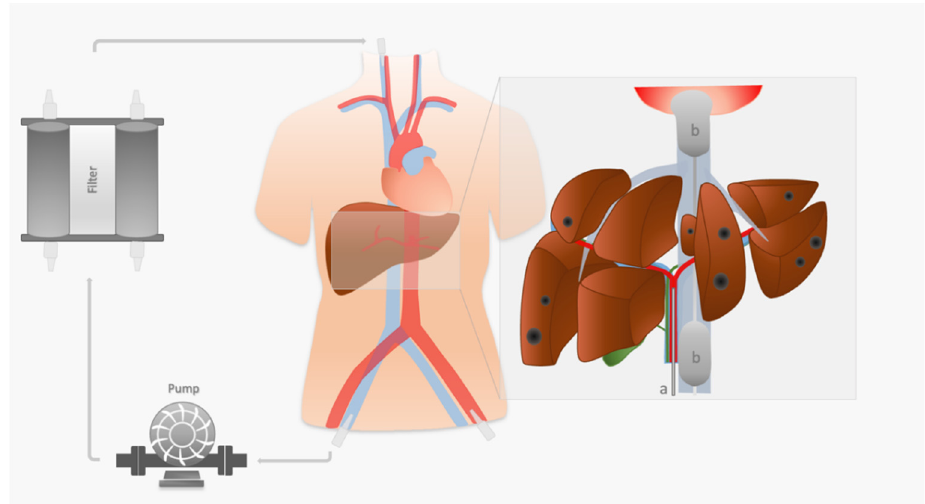
Figure 1. Overview of the PHP setup in a patient with inoperable disseminated hepatic metastases (dark spots on the magnified image of the liver). Introducer sheaths are inserted in the left common femoral artery and the right common femoral vein. A catheter ( a ) is placed in the proper hepatic artery to infuse melphalan in the diseased liver parenchyma (for overview reasons, we refrained from a supra-selective placement of the catheter). A double-balloon catheter ( b ) is inserted in the inferior vena cava (IVC). To isolate the hepatic segment of the IVC, the cranial balloon is inflated at the cavoatrial junction, and the caudal balloon is inflated below the confluence of the liver veins. The catheter in between the balloons is equipped with multiple side holes. Using the suction forces of a pump, the melphalan-enriched venous blood from the liver is pumped into an extracorporeal filtration system, which separates the melphalan from the blood before passing on the melphalan-cleansed blood to an introducer sheath place in the right internal jugular vein for systemic